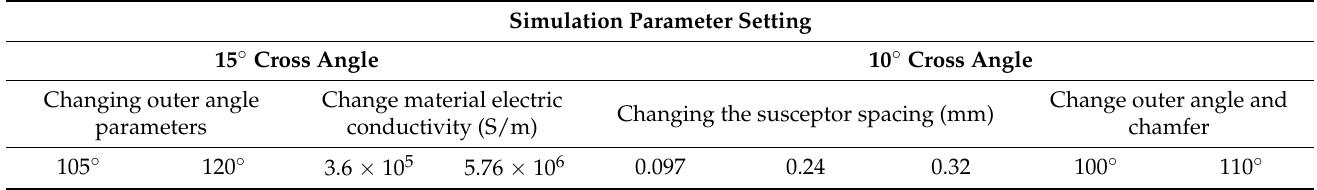
Table 5. Parameter settings of static mixer-type susceptor optimization